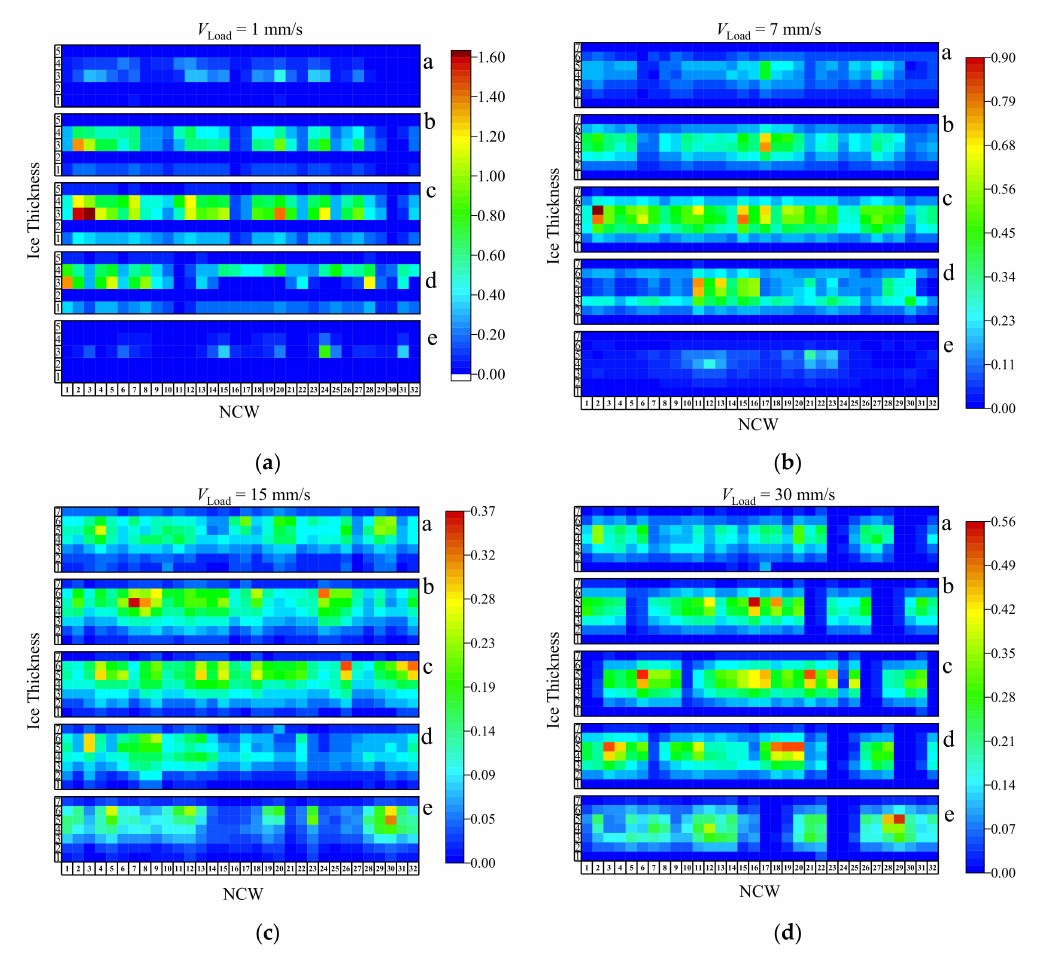
Figure 11. Distribution of local pressures in a period. ( a ) V load is 1 mm/s; ( b ) V load is 7 mm/s; ( c ) V load is 15 mm/s; ( d ) V load is 30